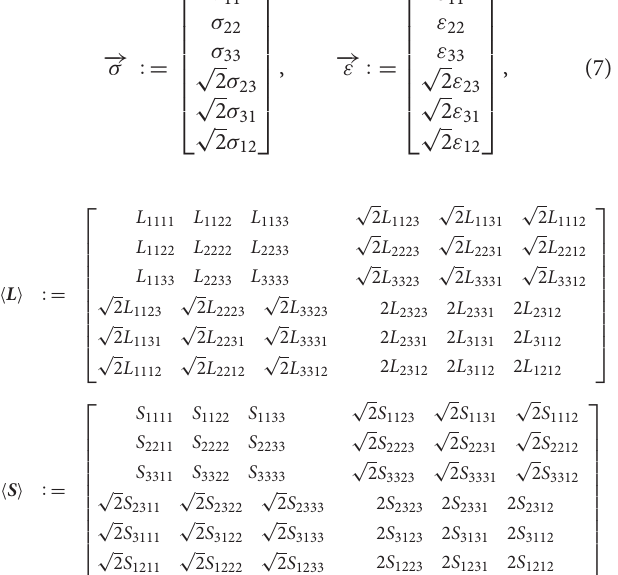
FIGURE 2 | Non-uniform σ xx field under uniform applied strain in the x direction within a cross-section in a three-dimensional volume simulation. The material properties used for this figure are E 1 the volume fraction is